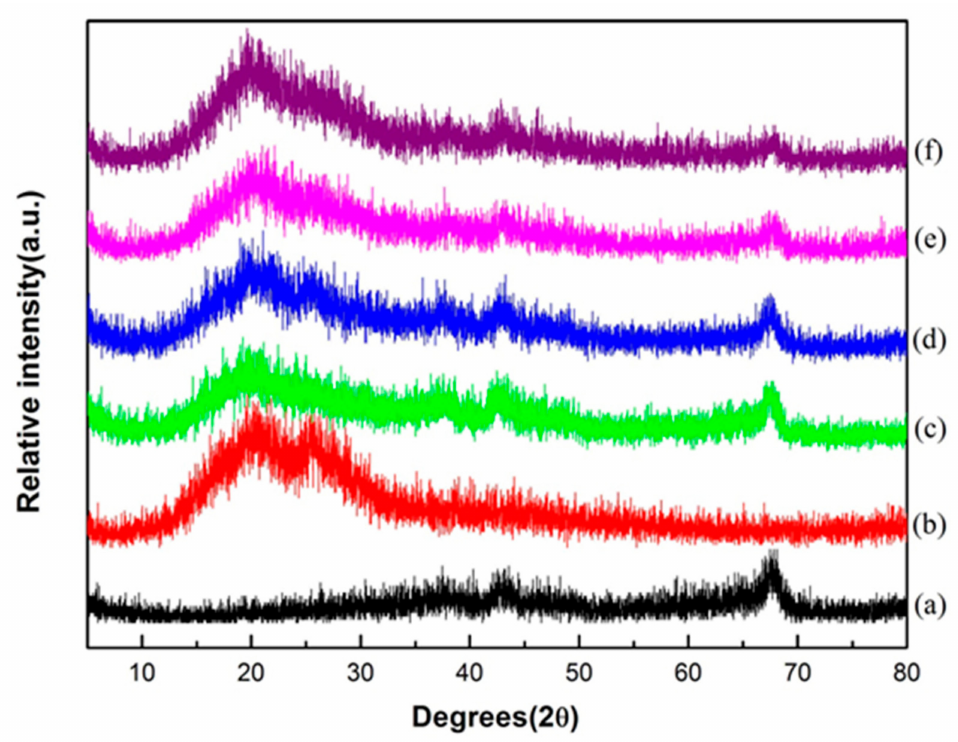
Figure 3. XRD patterns of (a) χ -Al 2 O 3 , (b) pure PANDB, and PANDB/ χ -Al 2 O 3 composites synthe- sized at AN/ χ -Al 2 O 3 weight ratios of (c) 0.5, (d) 1, (e) 1.5, and (f)